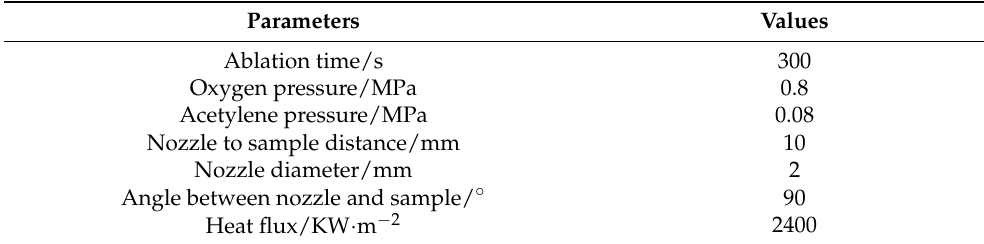
Table 1. Oxyacetylene ablative